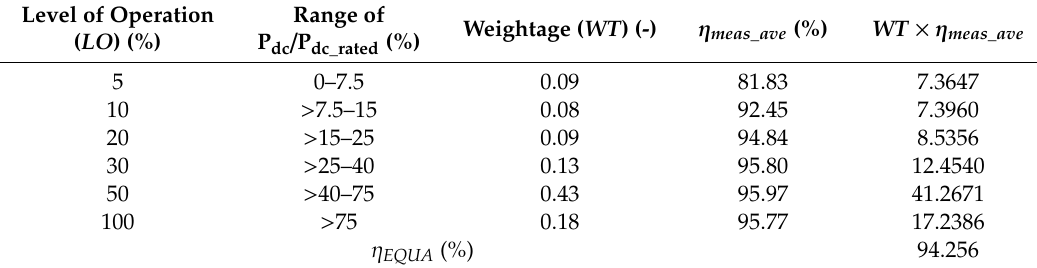
Weighted e ffi ciency for the SB3000HF inverter when G = Gi and T = 25 ◦ C with individual weightage.